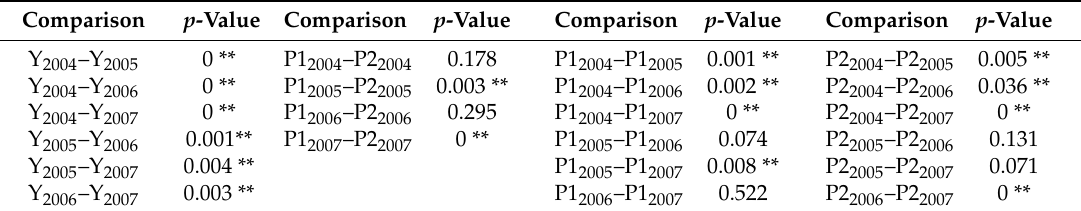
Table 3. Application of the proposal to HCFs in “Castilla La Mancha” (Spain). ** indicates statistical significance at 5%